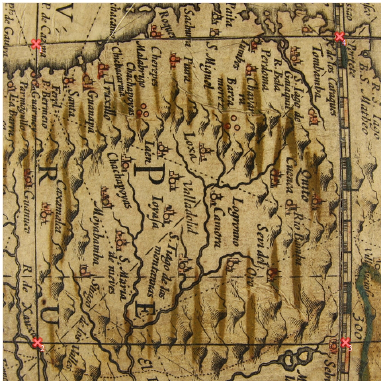
Figure 2. Manually determined tie points